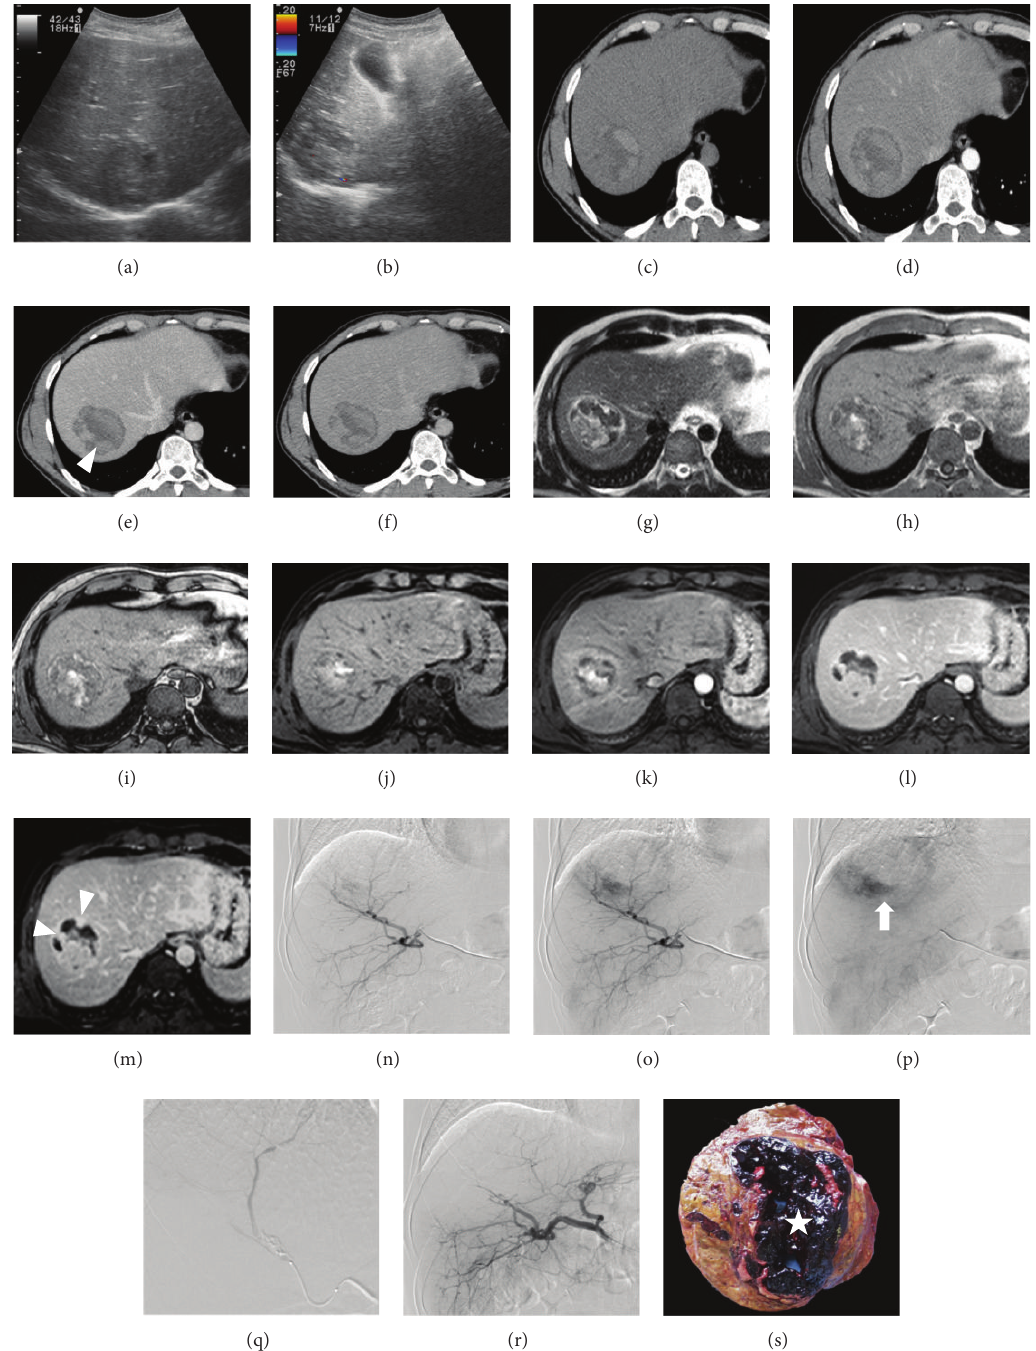
Figure 6: Bleeding adenoma in young man with sudden and acute upper abdominal pain. (a-b) Ultrasound, B-mode (a) and color-Doppler (b) imaging show heterogeneous lesion without significant vascularization. (c–f) CT confirms heterogeneous hyperdense bleeding mass with persistent vascularized tissue in the lower portion of the lesion (arrowheads). (g) Axial T2w image shows mixed heterogenous bleeding capsulated mass (arrows) in S VIII. (h-i) T1w in- and out-phased images confirm intralesional hemorrhage. (j–m) MR dynamic study shows vascularized tissue in the lower portion of the lesion (arrowheads). (n–p) DSA before embolization. Note hypervascular tissue in the lower part of the lesion (arrow). (q-r) DSA after embolization, complete devascularization of the nodule. (s) Cut section of the resected lesion shows large hemorrhagic component